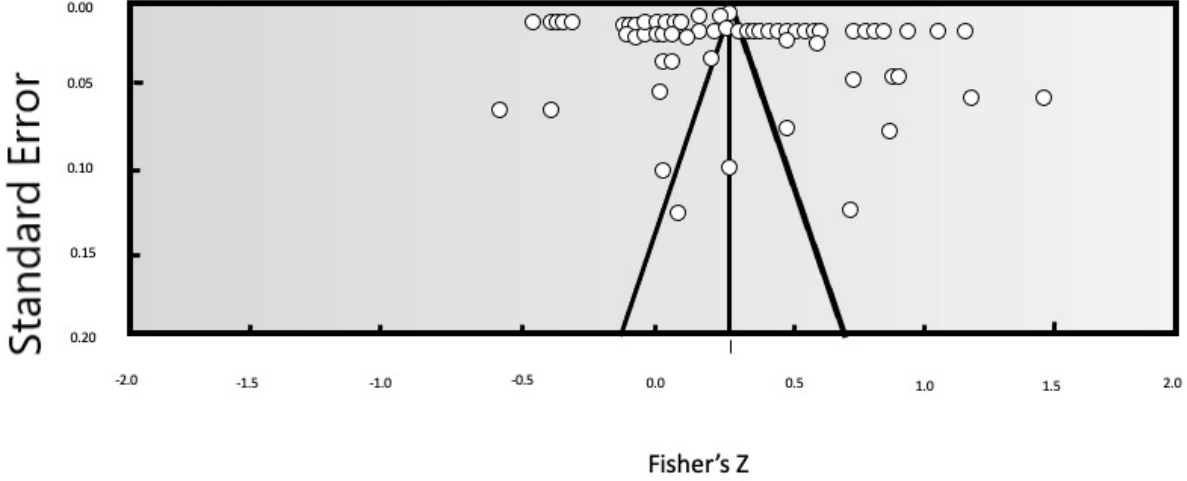
Figure 3. Funnel plot analysis of publication